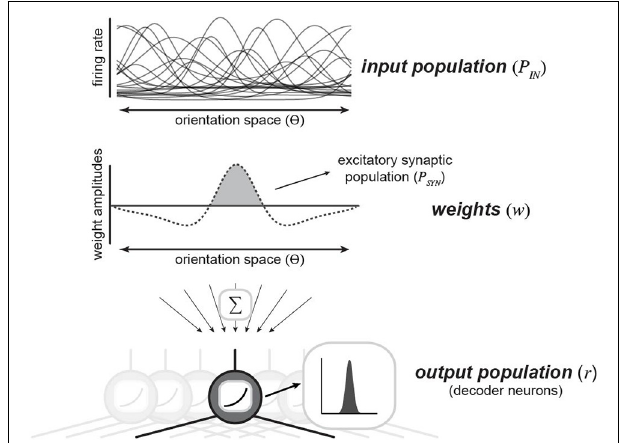
FIGURE 1 | A population decoding framework to study synaptic diversity. An upstream population of neurons is tuned for a single stimulus variable (orientation; top ). This input population is readout by downstream decoder neurons ( bottom ). Downstream neurons decode stimulus identification by reading out spikes from the upstream input population. Each decoder neuron is defined by set weights ( middle ) over the upstream population, which are summed and rectified to produce an